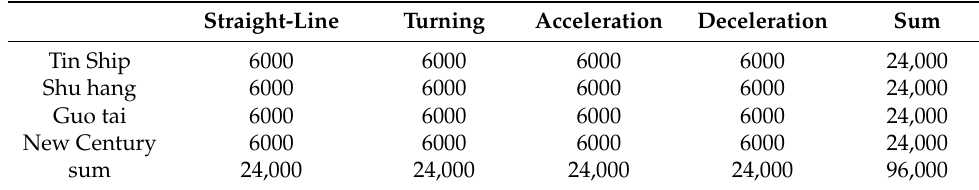
Table 3. Details of the dataset